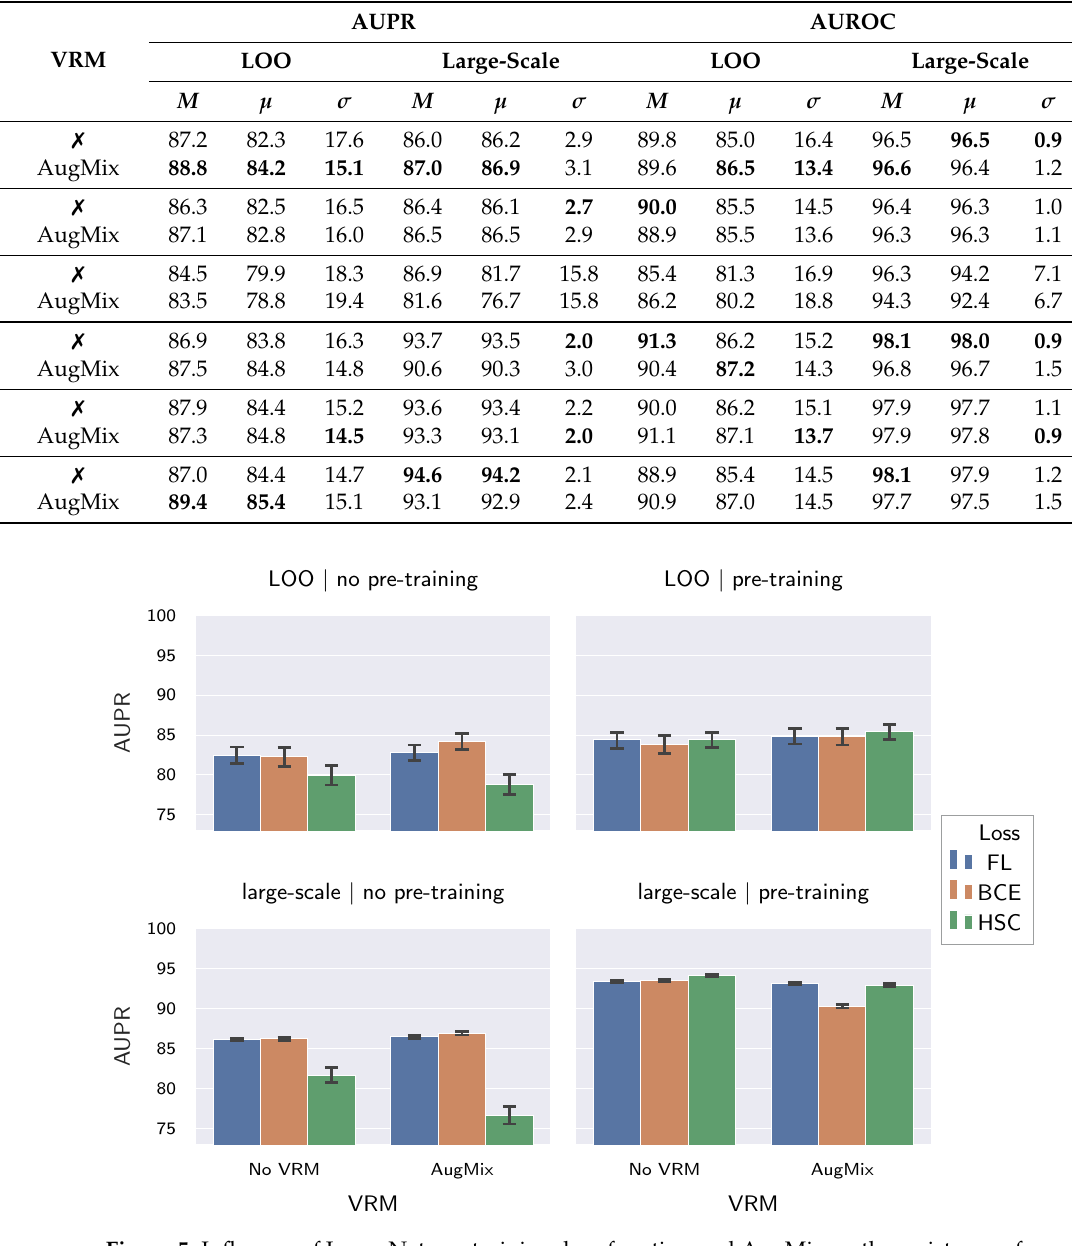
Figure 5. Influence of ImageNet pre-training, loss function and AugMix on the resistance of super- vised fabric AD methods to distribution shifts. We show both mean and 95% confidence interval (CI) for the AUPR achieved on the held-out fabrics, as well as on the large-scale